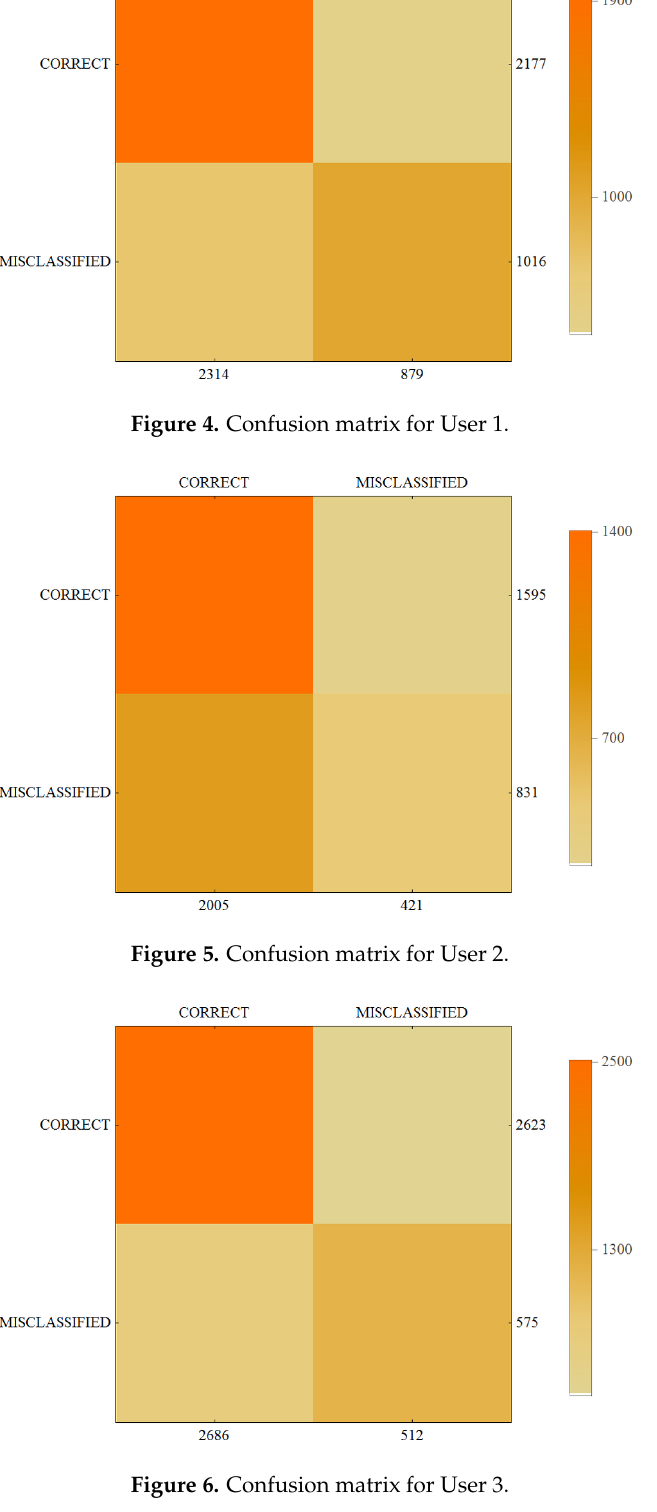
Figure 6. Confusion matrix for User